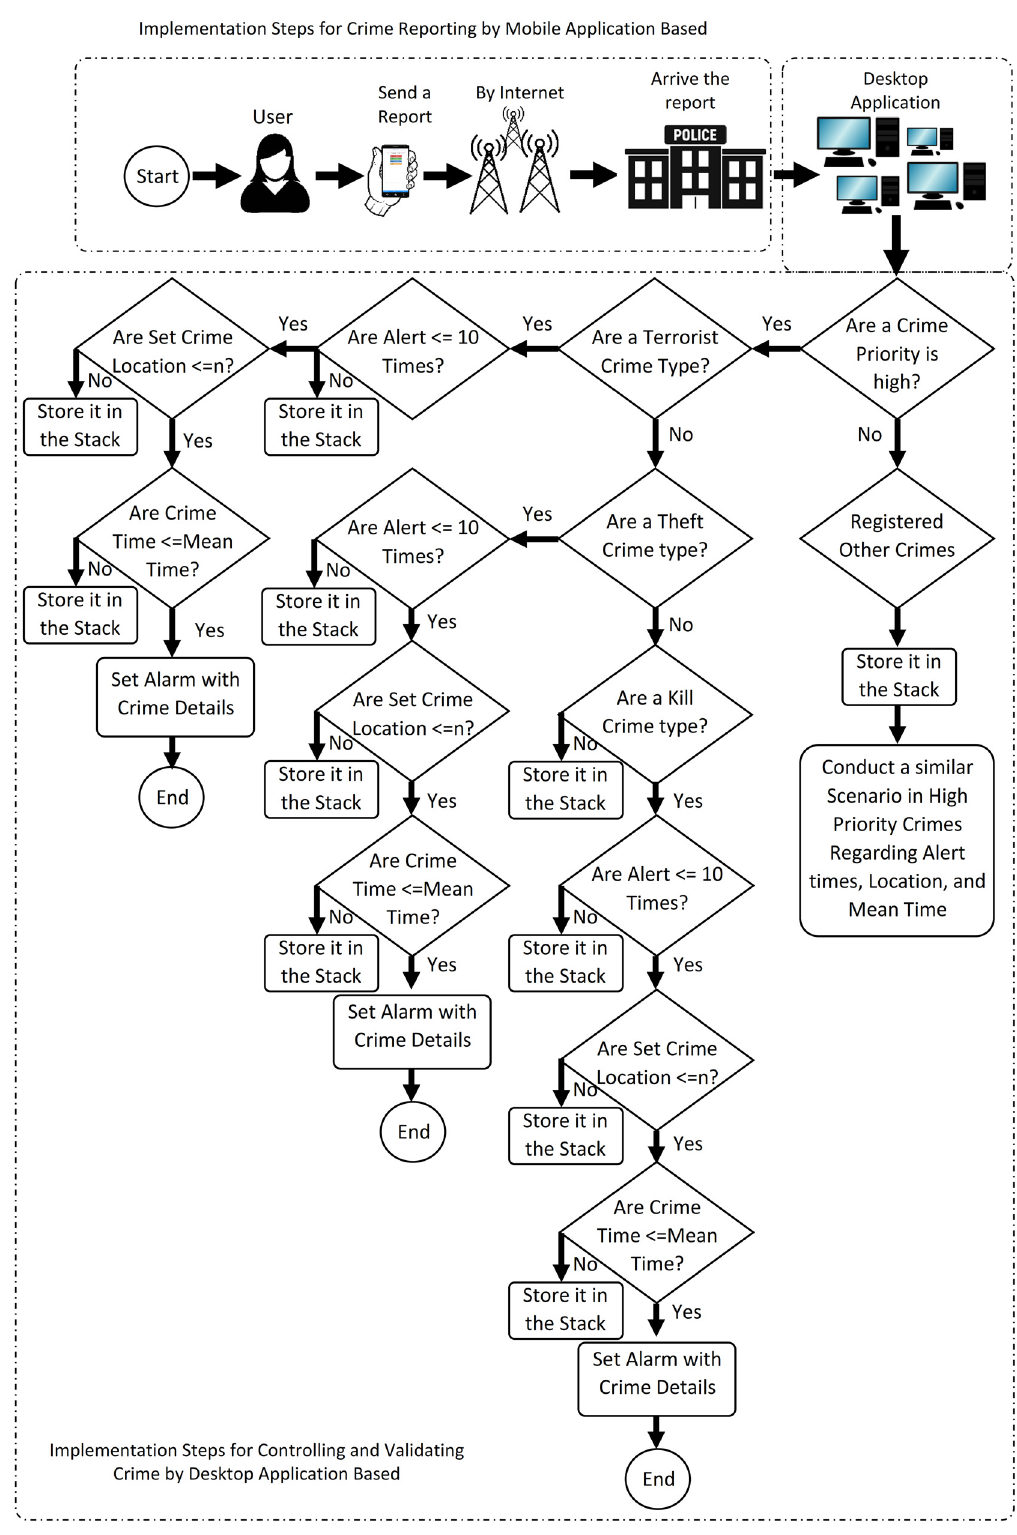
Figure 7: Implementation steps for the proposed